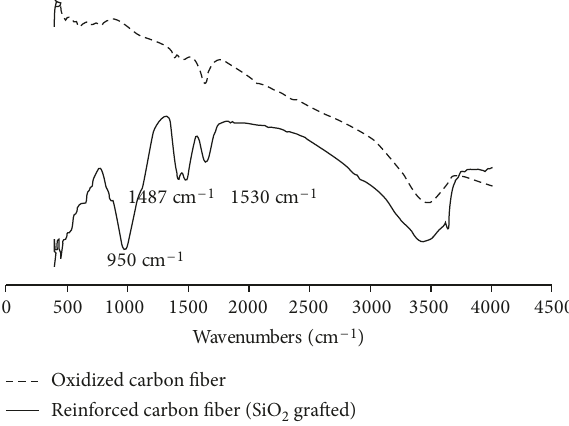
Figure 3: SEM image of carbon fi bers before and after oxidation treatment.